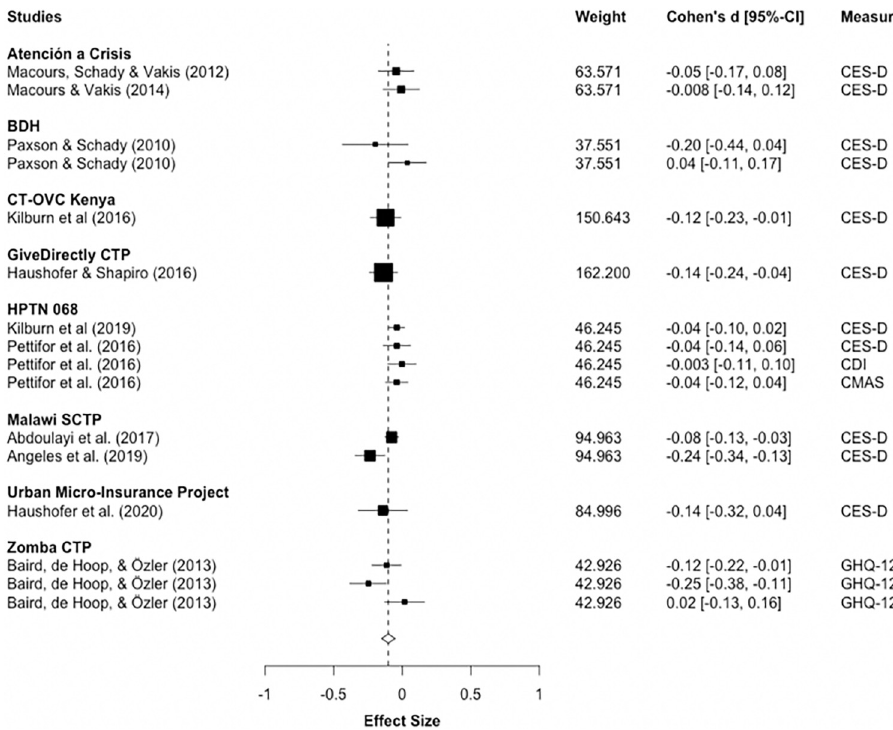
Fig 3. Depression and anxiety post-intervention. Notes: RVE correlated effects model with small-sample corrections. Robust standard errors adjusted at program-level. Outcomes are coded so that negative Cohen’s d-values indicate improvements. Diamond and dashed line display overall estimate of d pooled = -0.102, width of diamond represents 95%-CI [-0.15,-0.05].